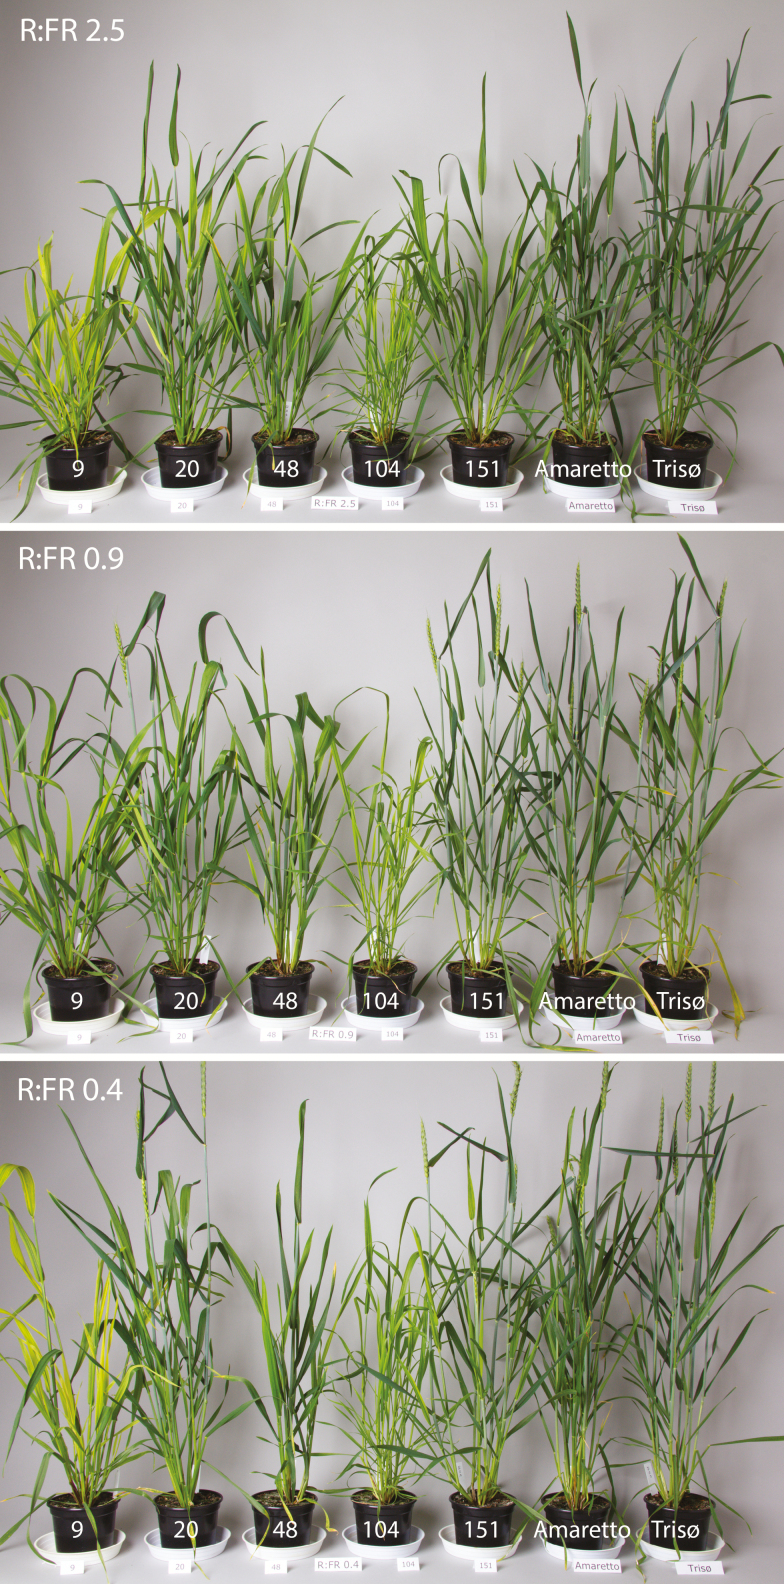
Selected mutant lines A9, A20, A48, T104 and A151 and two non-mutated cultivars Amaretto and Triso, grown in R:FR 2.5, 0.9 and 0.4. Photos were taken 8 weeks after sowing. Plants grown in R:FR 0.4 show a faster development, earlier spike emergence and anthesis than plants in R:FR 2.5.